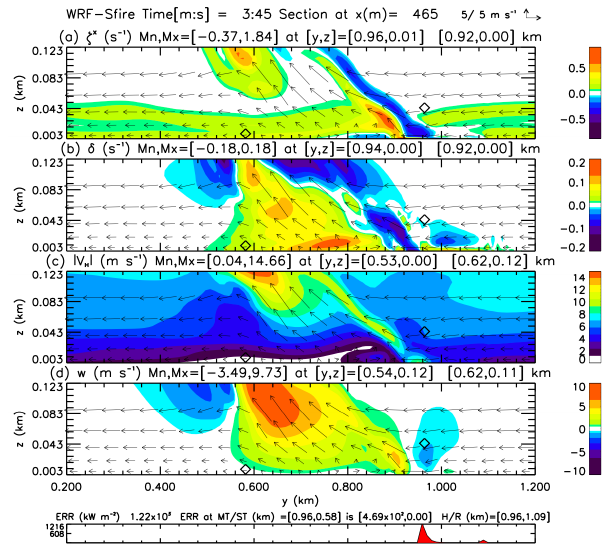
Fig. 11. As in Fig. 10 except for vertical y – z cross sections at x = 465m. The bottom plot displays the energy release rate (ERR) (kWm − 2 ) from the surface fire as a function of y . Maximum rear and head (R/H) distances (km) advanced by the fire are given, along with fire flux (ERR) values at the surface locations of the MT and ST. The top locations of the MT and ST are indicated by black dia-